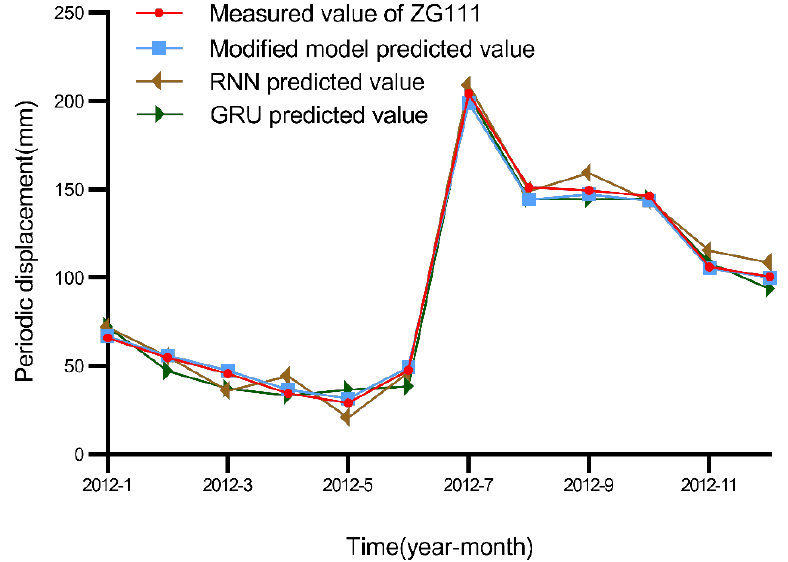
Figure 25. Periodic displacement predicted results of ZG111 using LSTM-FC, RNN and GRU models.